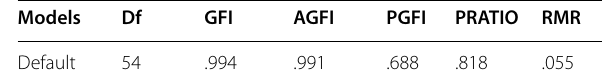
Table 3 Fit indexes